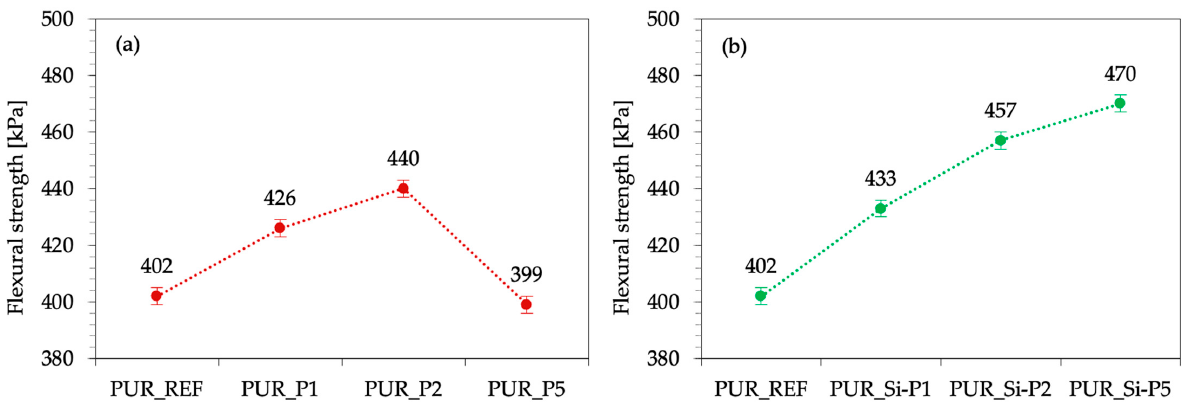
Figure 10. Effect of plum ( a ) and silanized plum ( b ) fillers’ content on the flexural strength of PUR foams.